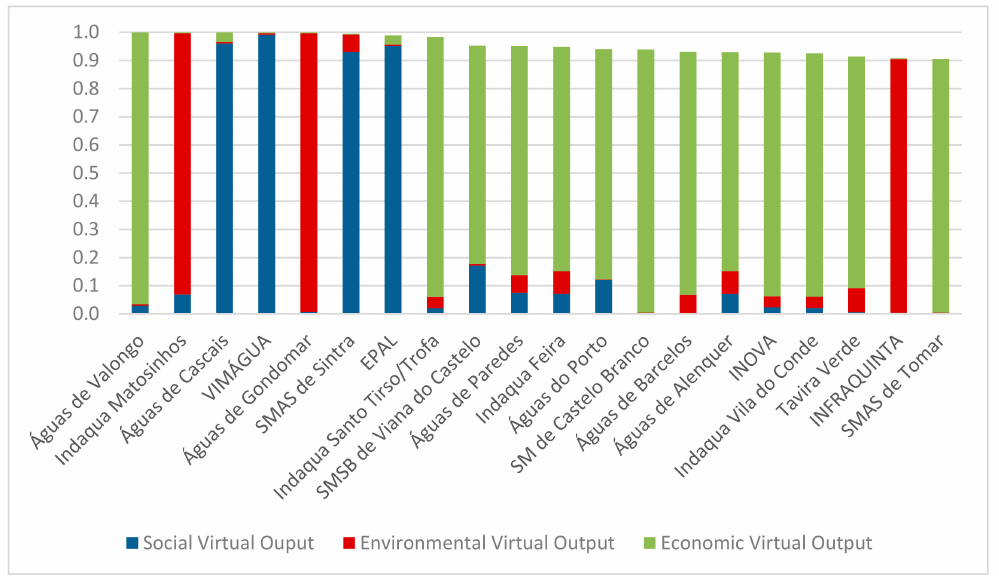
Figure 5. Contribution of each dimension partial indicator to the value of global composite